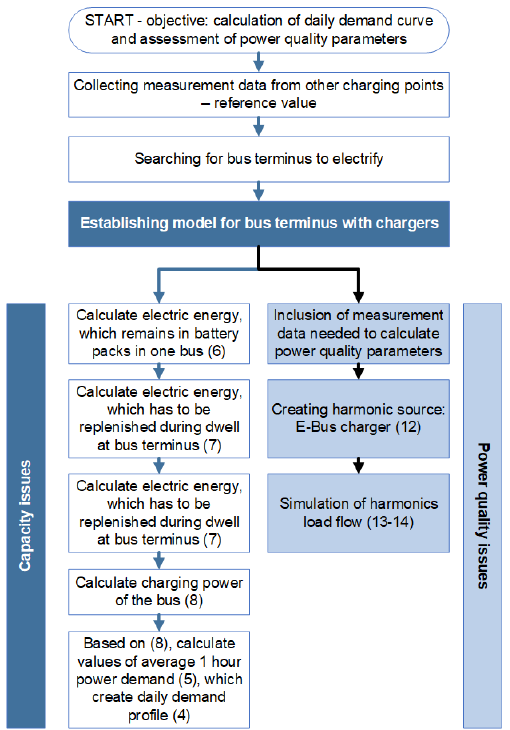
Figure 3. Block diagram of the electrification process of the bus terminus.